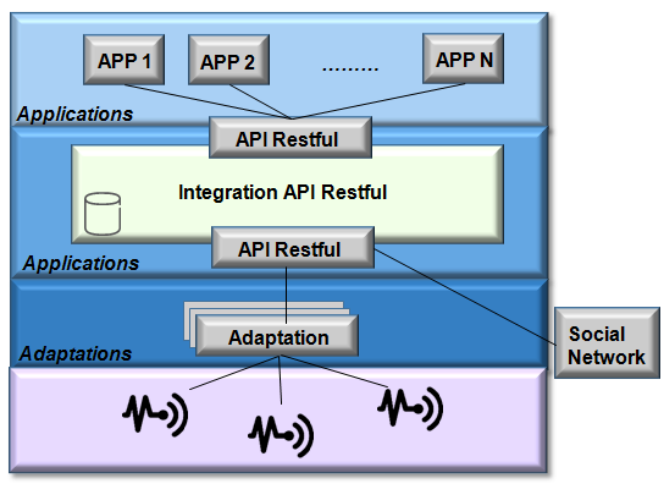
Figure 27. Illustration of the RestThings